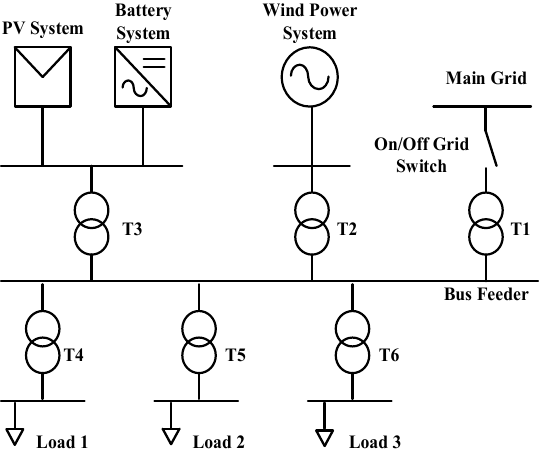
Figure 10. The architecture of microgrid under the island operation mode.